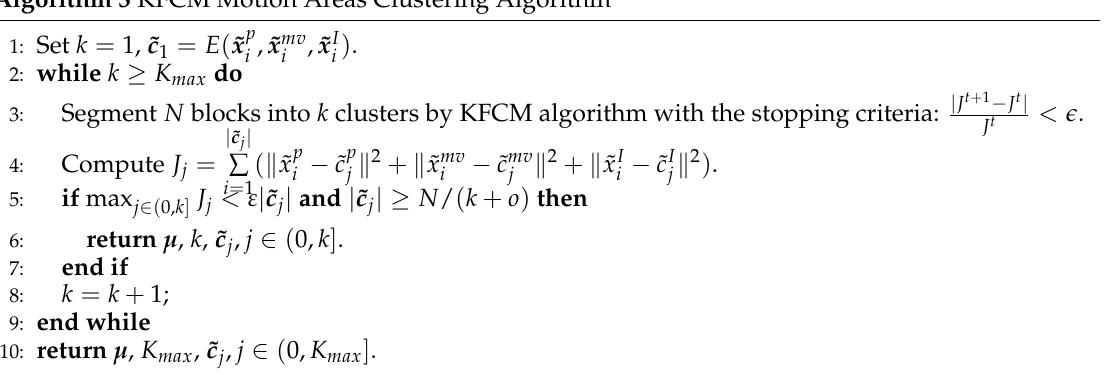
Algorithm 3 KFCM Motion Areas Clustering Algorithm